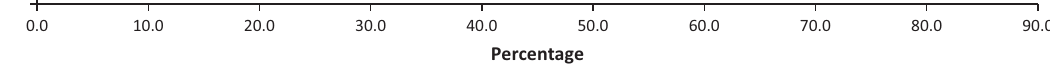
FIGURE 4: Tembisa, percentage of enterprise category situated on the high